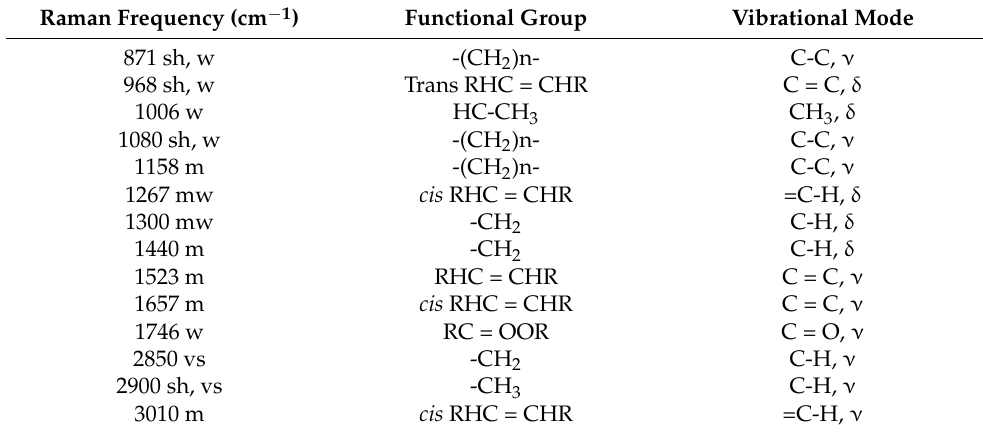
Table 1. Assignment of Raman frequencies that identify the vegetable oil of Spondias mombin L. Abbreviations: vs, very strong; m, medium; w, weak, mw, medium weak; sh, shoulder; ν , stretching; δ ,